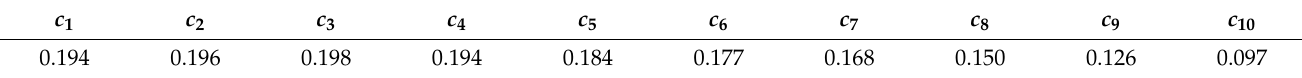
Table 1. The wing chord distribution of a seagull